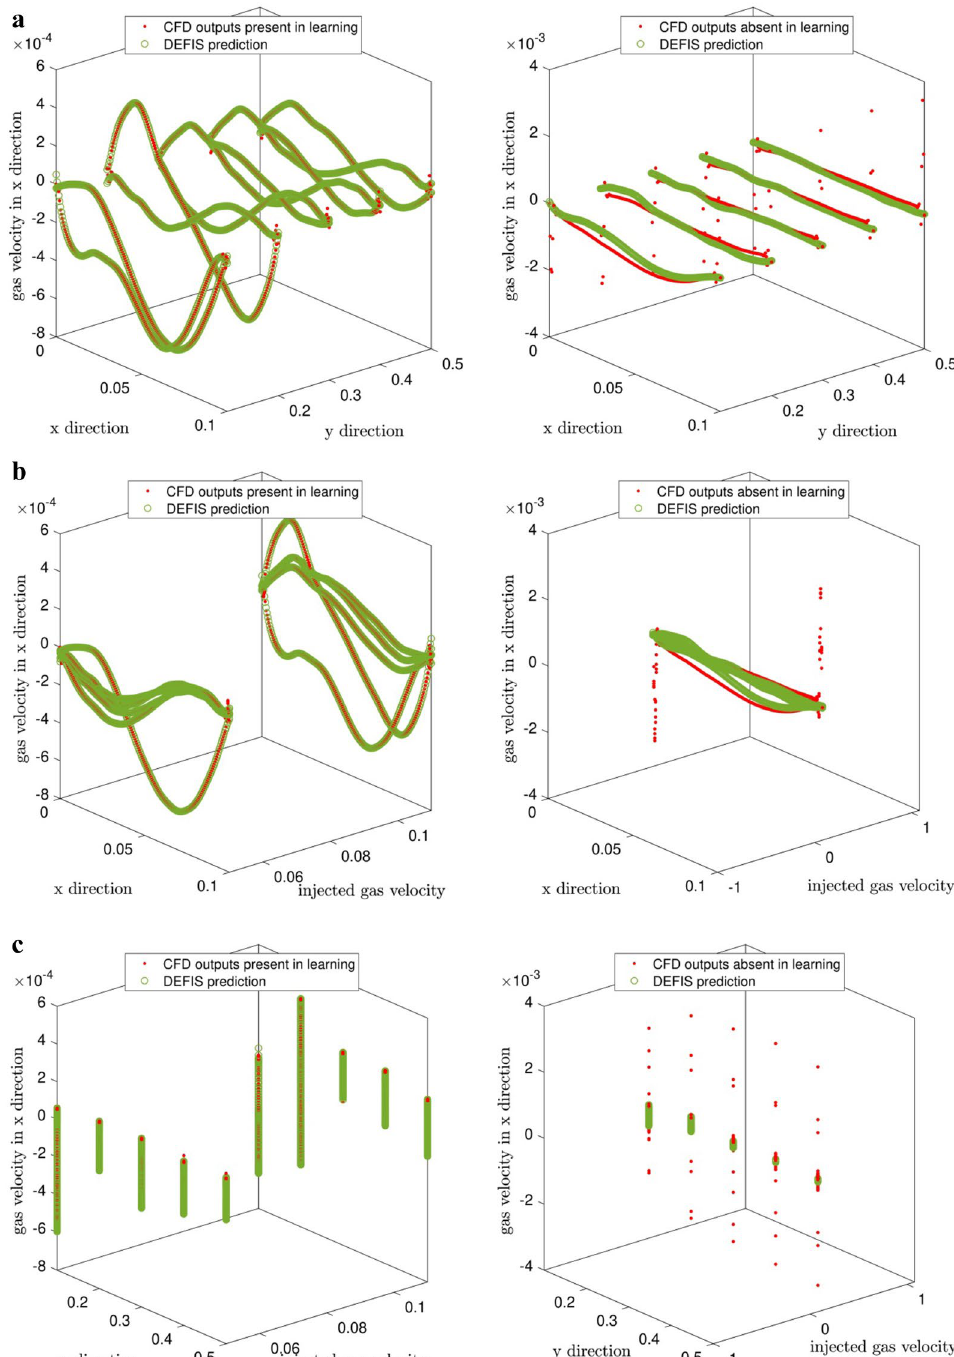
Figure 6. ( a ) Comparison of predicted gas velocity and CFD output (gas velocity) which is present in DEFIS learning (in left figure) and comparison of predicted gas velocity and CFD output (gas velocity) which is absent in DEFIS learning (the right figure) (with considering inputs 1 and 2). ( b ) Comparison of predicted gas velocity and CFD output (gas velocity) which is present in DEFIS learning (in left figure) and comparison of predicted gas velocity and CFD output (gas velocity) which is absent in DEFIS learning (in right figure) (with considering inputs 1 and 3). ( c ) Comparison of predicted gas velocity and CFD output (gas velocity) which is present in DEFIS learning (in left figure) and comparison of predicted gas velocity and CFD output (gas velocity) which is absent in DEFIS learning (in right figure) (with considering inputs 2 and